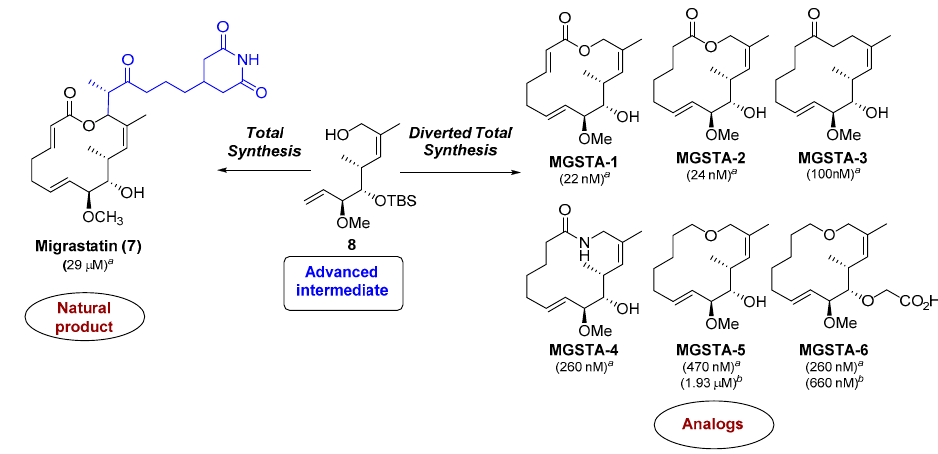
Figure 2. Diverted total synthesis approach for the preparation of migrastatin ( 7 ) and truncated analogs MGSTA-1,6 from a common advanced intermediate ( 8 ). IC 50 values (in parentheses) in boyden chamber assays against a 4T1 mouse mammary cancer and b A549 human lung cancer cells.